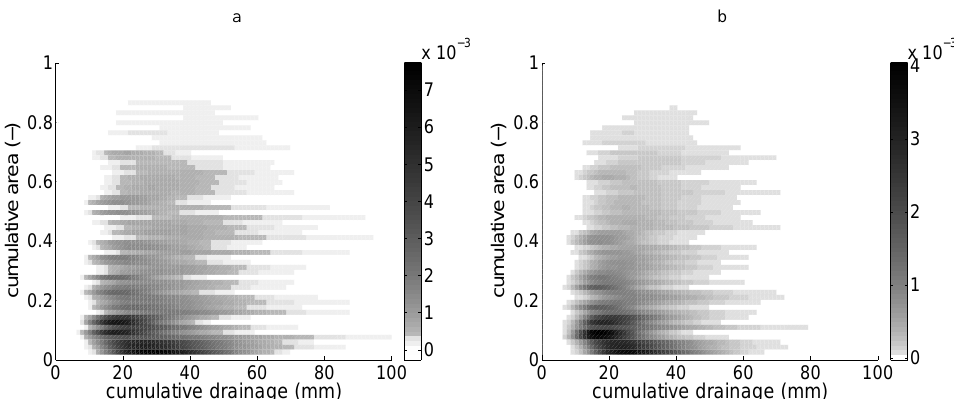
Fig. 11. Scaled solute flux density (d − 1 ) from simulations, at 0.5m depth, for a steady state atmospheric flux of 2.5mmd − 1 . (a) Tracer,